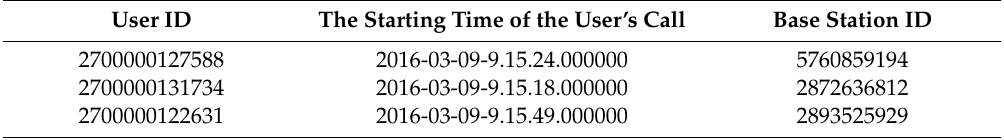
Table 1. The call detail record data.